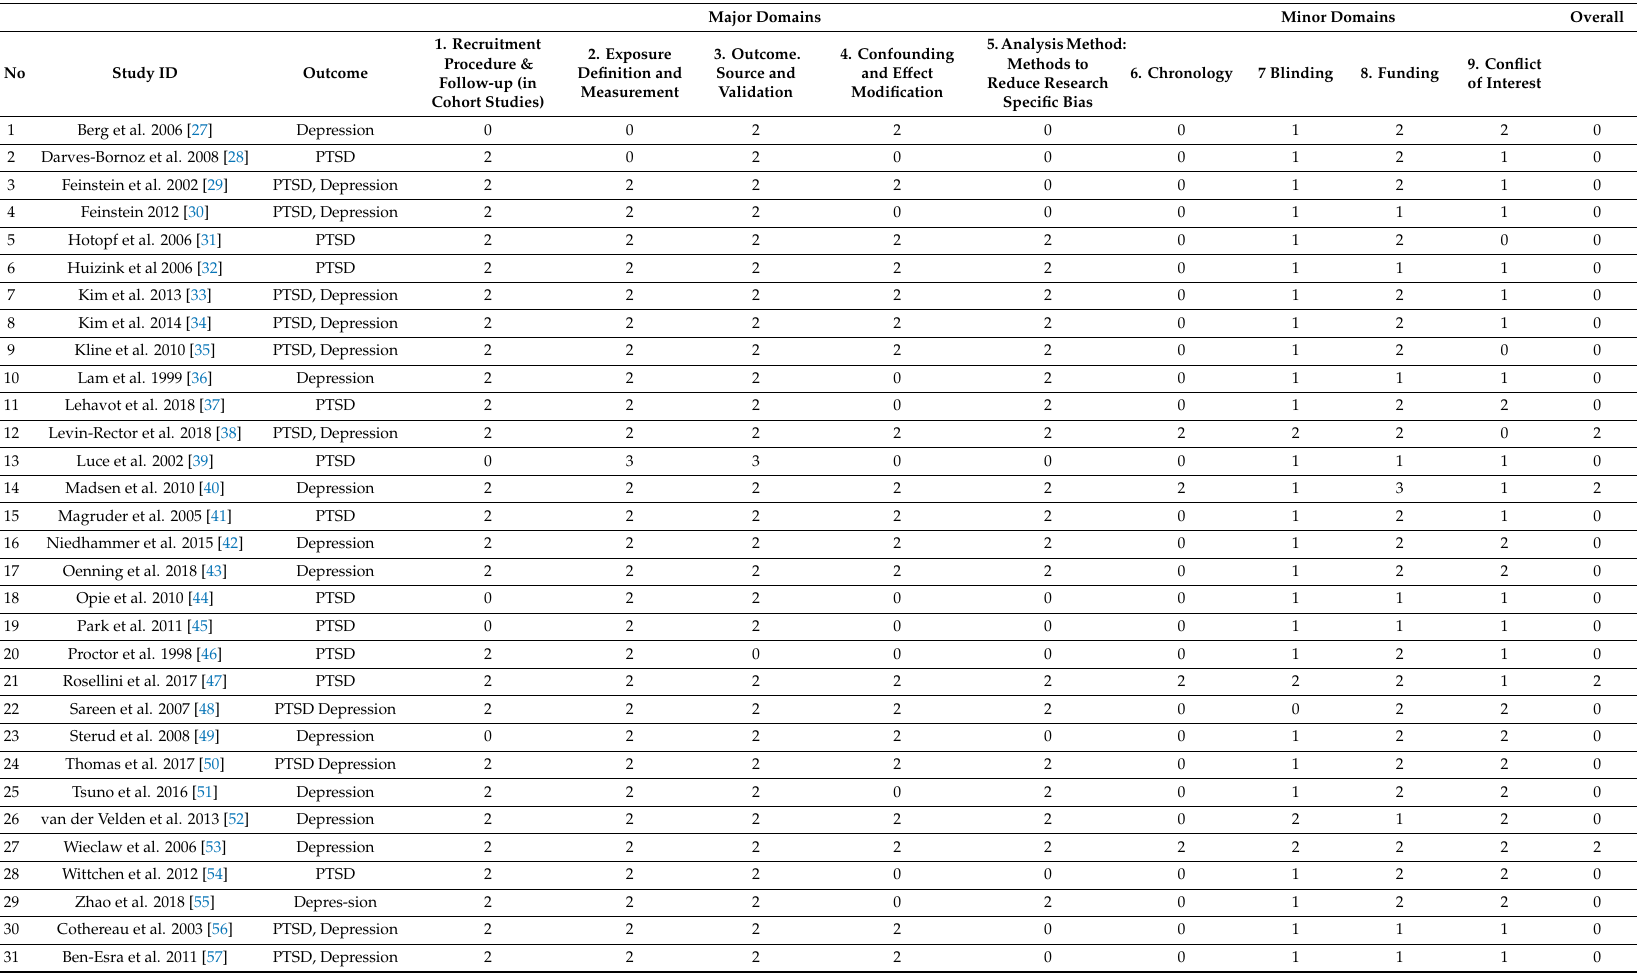
Low risk of bias 2. High risk of bias 0. Unclear risk of bias